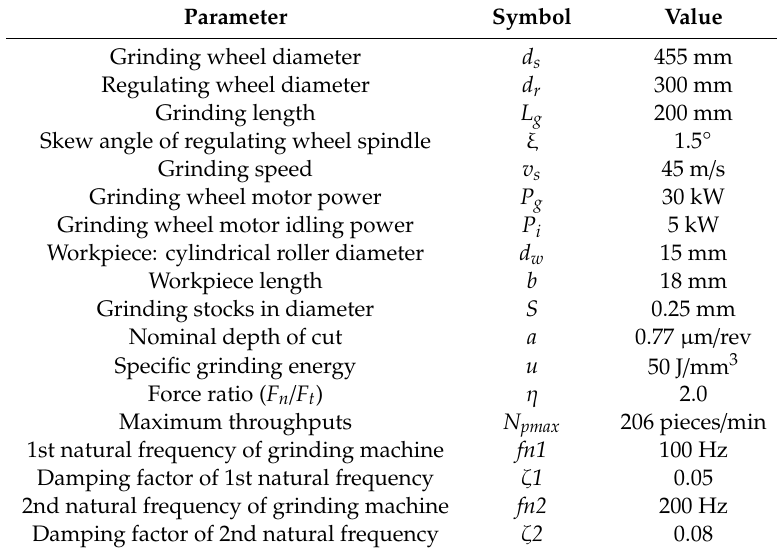
Table 1. Machine specifications and grinding conditions.